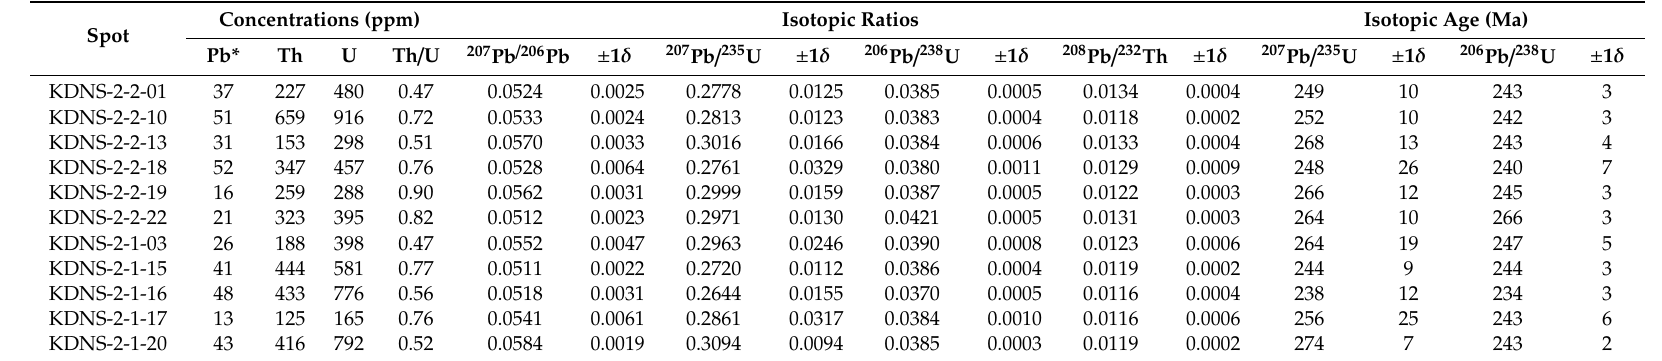
Table 1. Zircon LA-ICP-MS U–Pb data of the ore-hosting rhyolitic tu ff in the Kendenongshe polymetallic